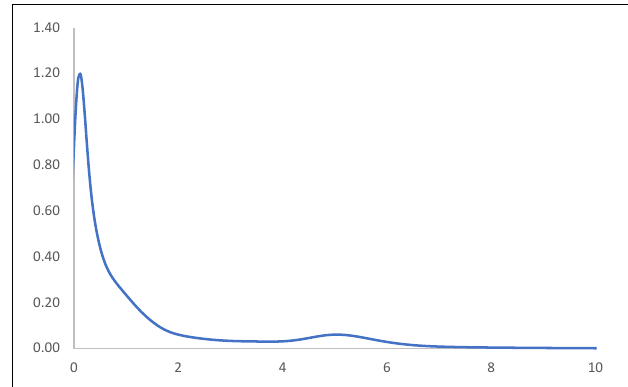
FIGURE 5 | Ergodic distribution for the relative RSVAPC of all countries with annual transitions. Source: Authors’ calculation. N.B. The vertical axis indicates the density of probability and the horizontal axis indicates RSVAPC values.